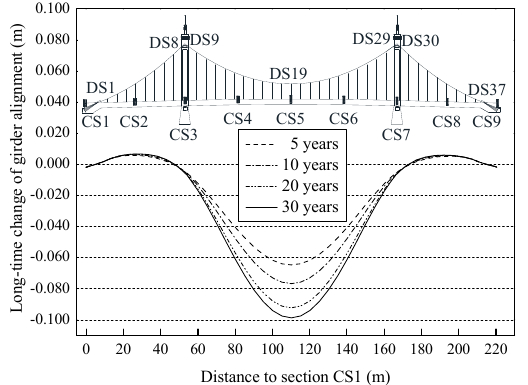
Figure 14. Predicted long-time changes of girder alignments.